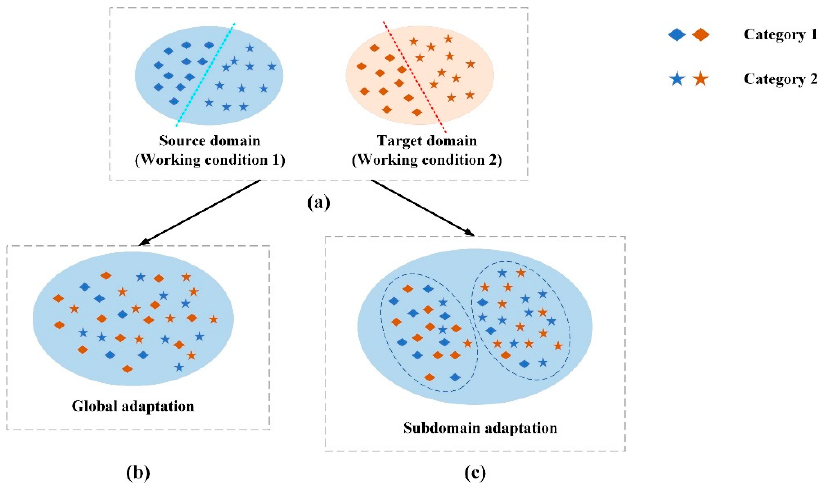
Figure 3. Subdomain adaptation schematic: ( a ) source and target domain conditions; ( b ) global adaptation; ( c ) subdomain adaptation